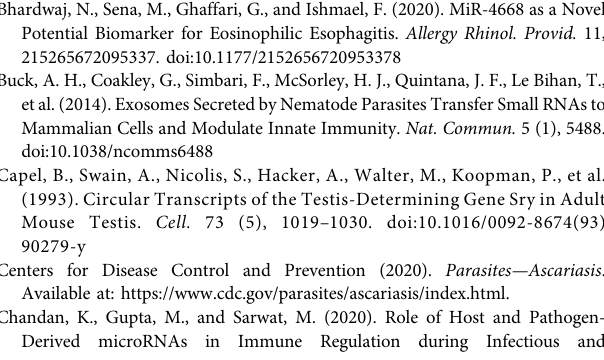
Supplementary Table S1 | List of ovary and body wall speci fi c circRNAs. Supplementary Table S2 | Primer table for primers used during qPCR validation. Primer sequence table for circRNA qPCR validation and primers for MEGAScript T7 RNA spike